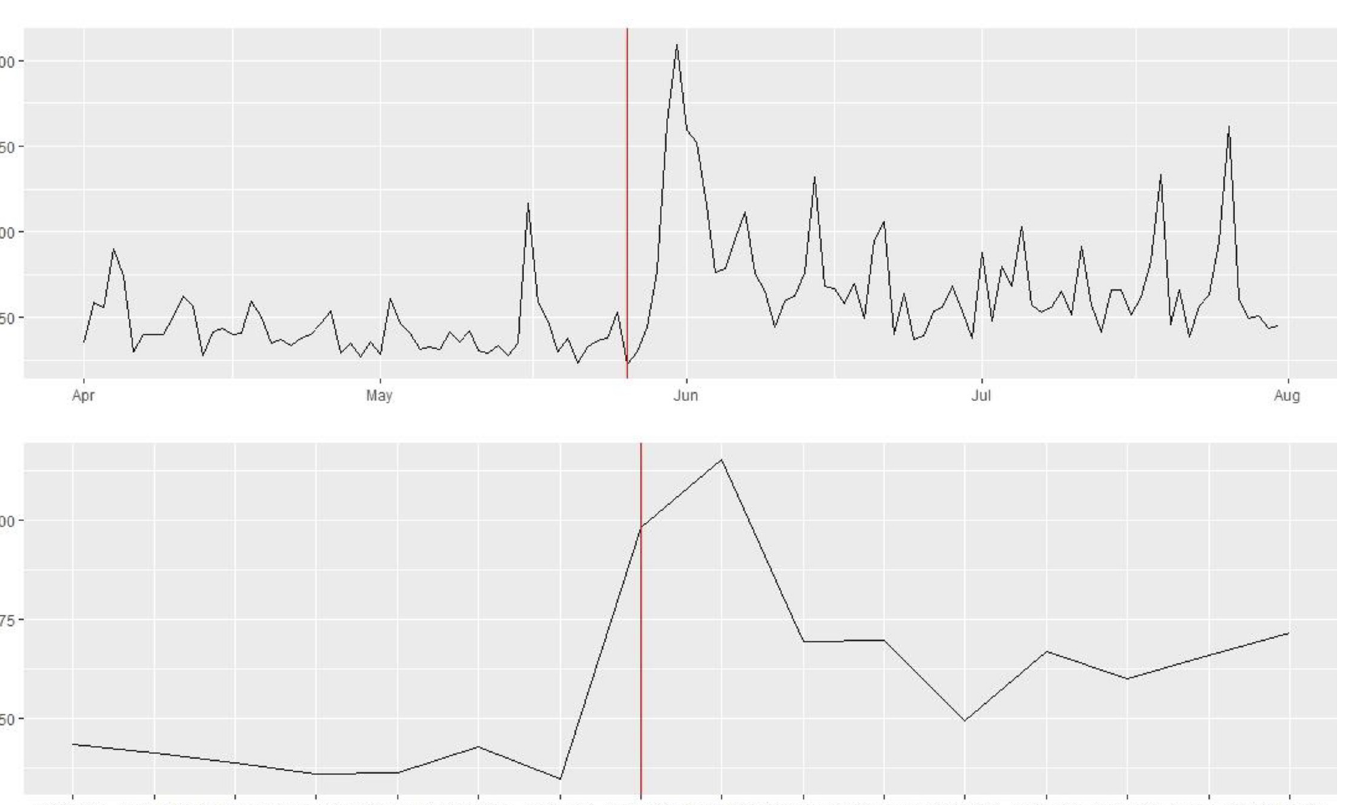
Fig 2. Public reactions (i.e., average number of favorites per tweet) to tweets posted by the 115 major police departments in the U.S. before and after the killing of George Floyd on May 25 th , 2020 (above: Daily information; bottom: Weekly